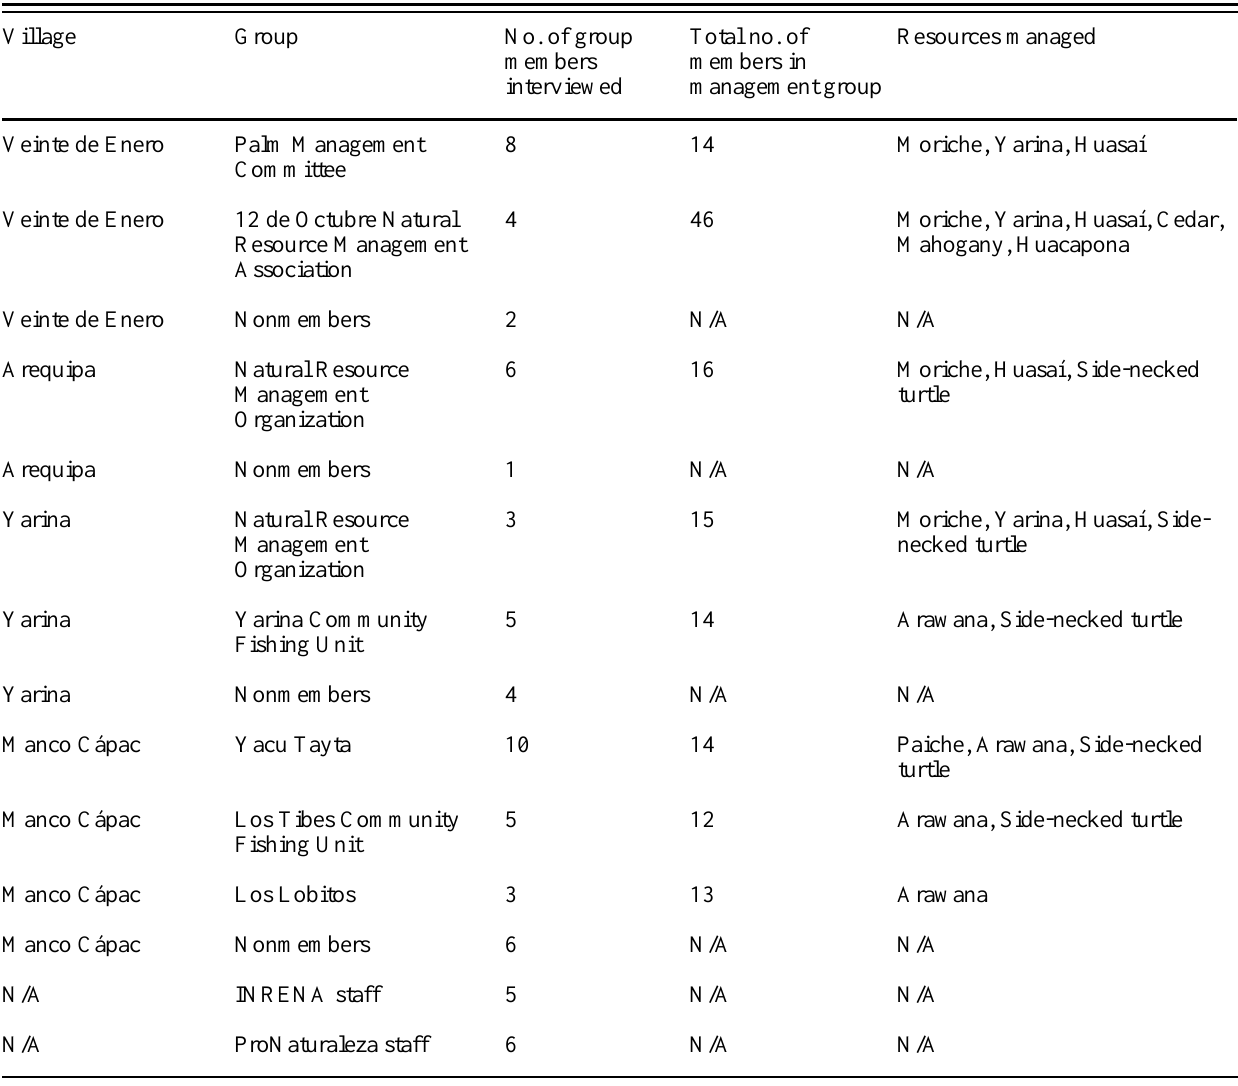
Table 1. Groups interviewed for